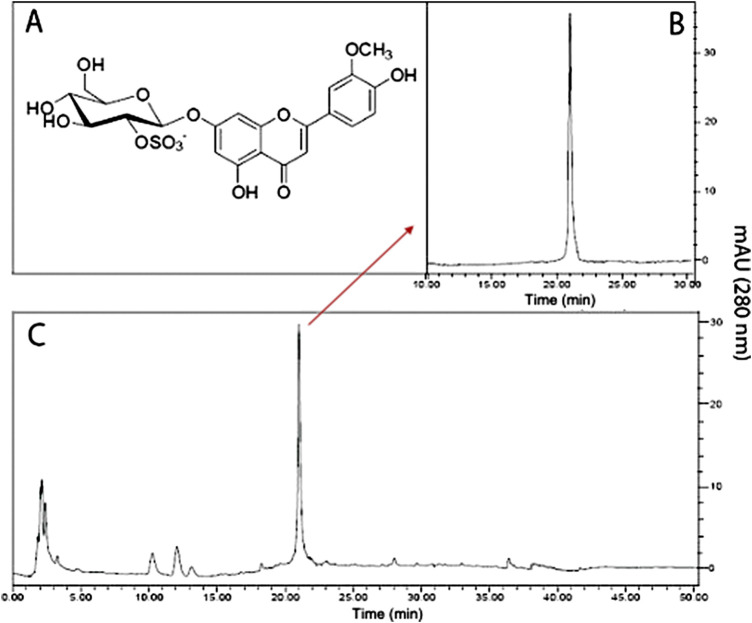
Chromatographic profile of thalassiolin B isolated from T. testudinum hydroethanolic extract. (A) Chemical structure of thalassiolin B (chrysoeriol 7-β-D-glucopyranosyl-2"-sulphate), the main component of T. testudinum extract. (B) HPLC of thalassiolin B standard. (C) HPLC profile of T. testudinum hydroethanolic extract. Adapted from: Garateix et al., 2011. The authors have the rights to share this figure.